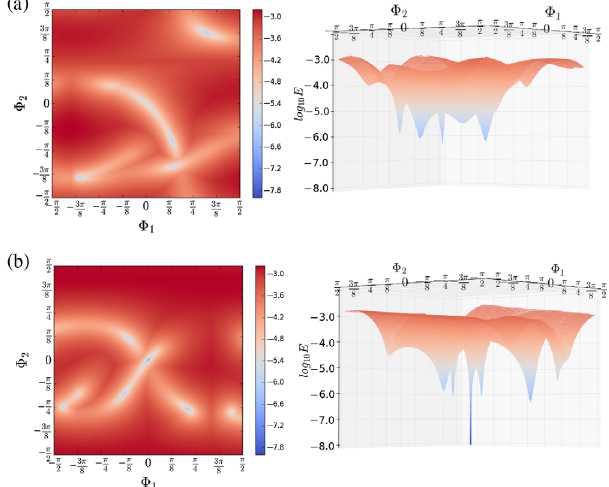
FIG. 6. Energy landscape of a quad loop pattern at a fixed norm of folding angles ∥ ρ ∥ . (a) A generic quad loop pattern has three to seven folding branches seen as minima in the energy landscape. Left: Heat map. Right: Corresponding three- dimensional surface. Generic minima have energies that scale as E ∼ ρ 4 . (b) By solving loop equations [38,39], we can design one specific folding branch to be qualitatively softer than all others (identified as the much deeper minimum). The rest of the branches retain their original energy scaling and thus become distractors in the energy